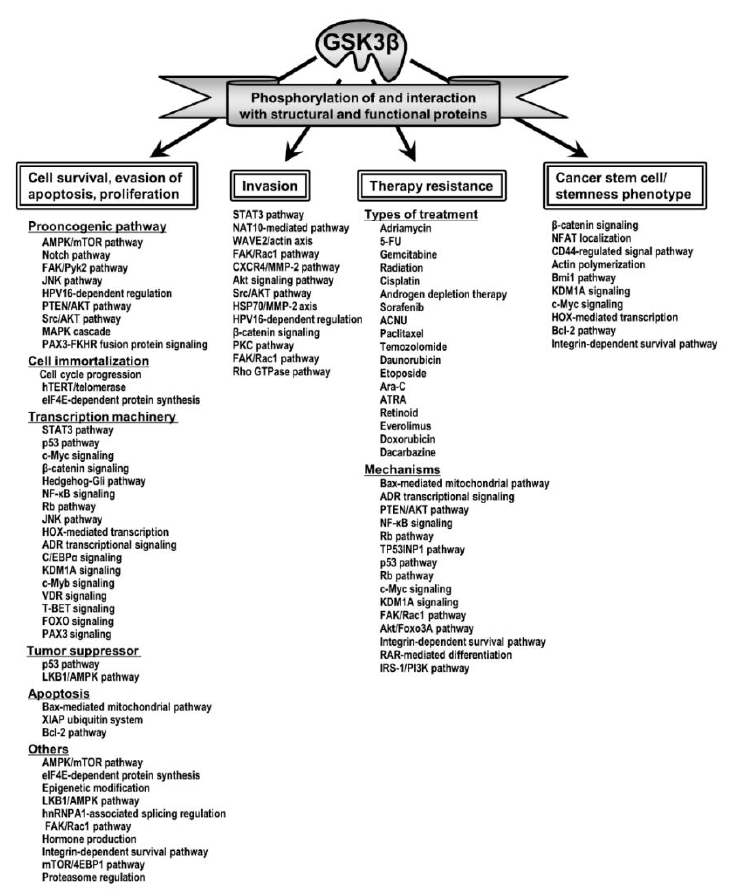
Figure 1. The tumor-promoting roles of GSK3 β and the underlying mechanisms and pathways reported in the literature.